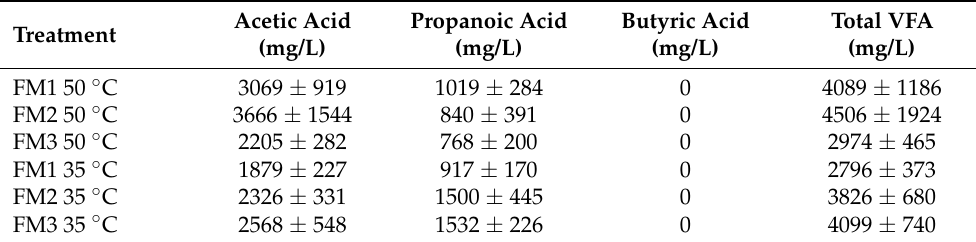
Table 2. Average volatile fatty acids during the last five weeks of the assay under the steady state (after ten weeks).